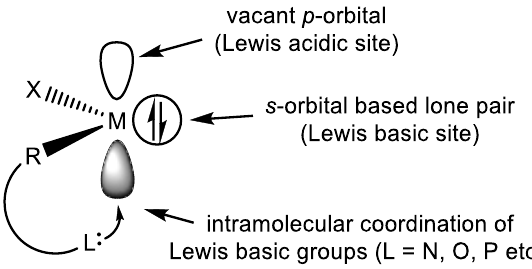
Figure 1. Stabilization of stannylene [Sn(R-L) 2-x (X) x )] complexes.